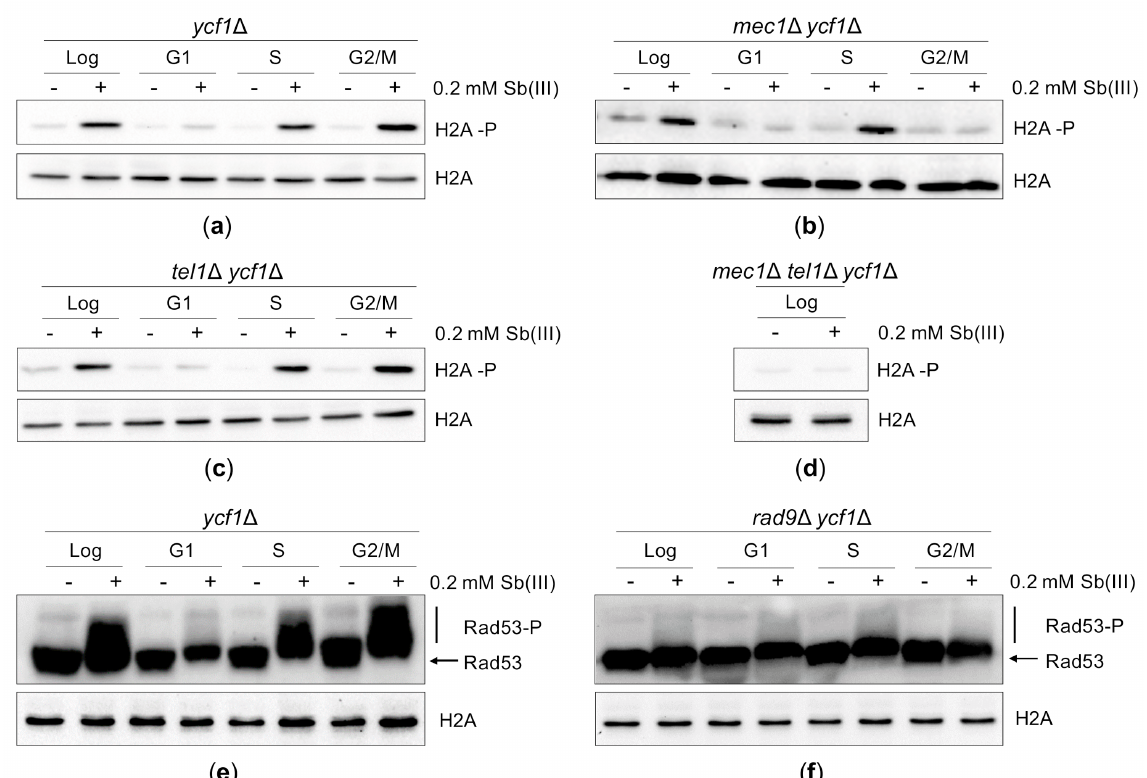
Figure 4. Sb(III) activates DNA damage response in budding yeast. ( a – d ) Sb(III) induces Mec1/Tel1-dependent histone H2A phosphorylation at S129 (H2A-P) in S and G2/M but not in G1 phase of the cell cycle. Cells were grown logarithmically (Log), synchronized and kept arrested in G1 with α -factor (G1), synchronized in G1 and released from the α -factor block to allow DNA replication (S) or synchronized and kept arrested in G2/M with nocodazole (G2/M) followed by treatment with 0.2 mM Sb(III) for 2 h or mock-treatment. Next, total protein extracts were prepared and analyzed by western blot using anti-phospho H2A (S129) and anti-H2A antibodies as a loading control. The lethality of mec1 ∆ mutation was suppressed by deletion of the SML1 gene encoding a ribonucleotide reductase inhibitor. ( e , f ) Sb(III) triggers Rad9-dependent hyperphosphorylation of Rad53 (Rad53-P). The ycf1 ∆ and rad9 ∆ ycf1 ∆ cultures were prepared and treated as described above. Western blot analysis was performed with anti-Rad53 and anti-H2A antibodies as a loading control (source data are shown in Supplementary Figure